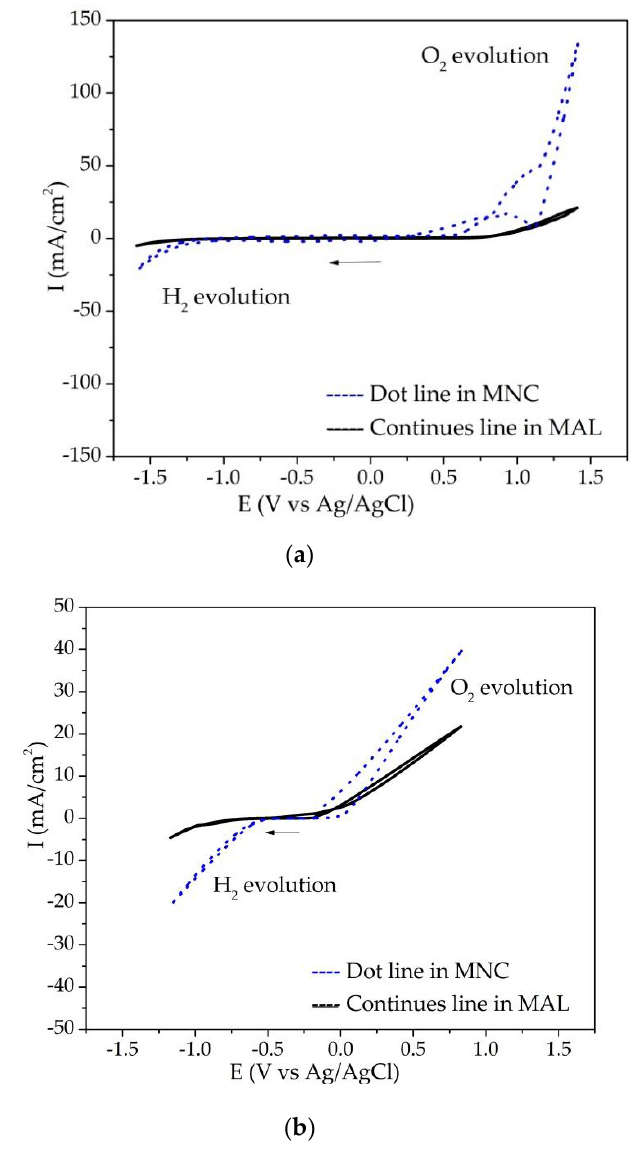
Figure 5. Cyclic voltammetry at 50 mV / s from the Eoc of the ( a ) IrO 2 -Ta 2 O 5 / Ti y ( b ) NiCoB / CS coatings.